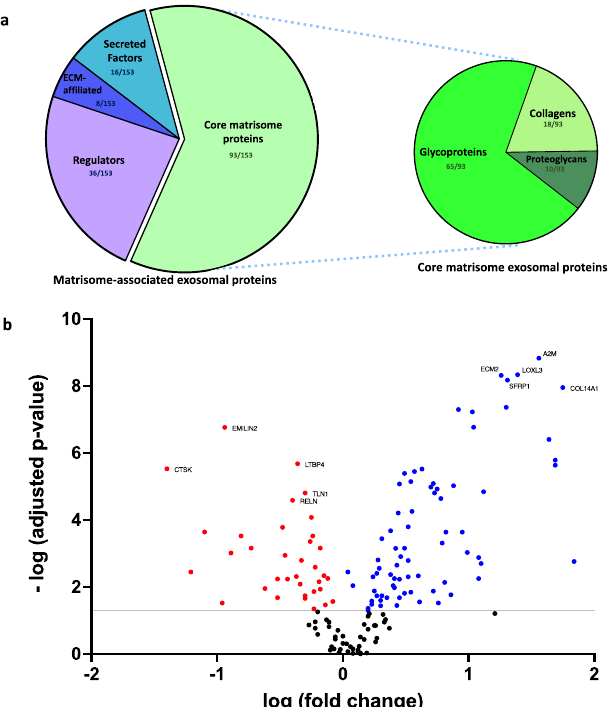
Figure 4. Exosomes secreted by skin fibroblasts cultured in 3D transports more proteins that are parts of the matrisome. Pie charts showing the number of matrisome-associated and core matrisome proteins that were quantified within the exosomes derived from fibroblasts ( a ). Volcano plot of matrisome-associated and core matrisome exosomal proteins ( b ). The blue dots represent significantly upregulated proteins, the red dots represent significantly downregulated proteins, and the black dots represent insignificant differentially expressed proteins. The grey line indicates an adjusted p-value of 0.05. The 5 most significantly upregulated and downregulated proteins are